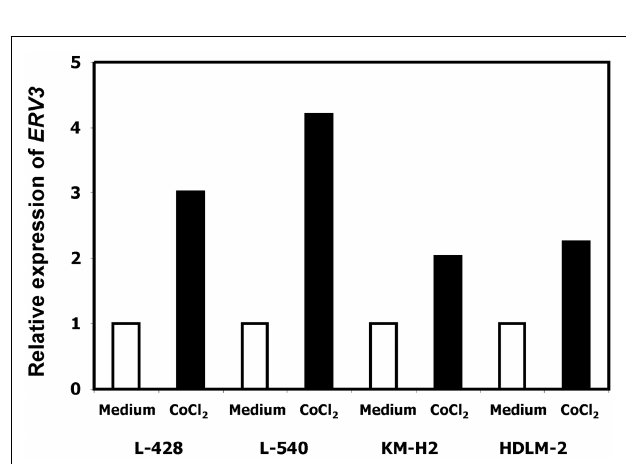
FIGURE 5 | Incubation of HL cells with cobalt(II) chloride inhibits proliferation . Cells of the indicated cell lines were cultured in the presence or absence of 200 µ M cobalt(II) chloride for 4days.Thereafter the cell number was determined. Percentage of increase in cell number was calculated as [(final cell number)/(starting cell number) × 100].